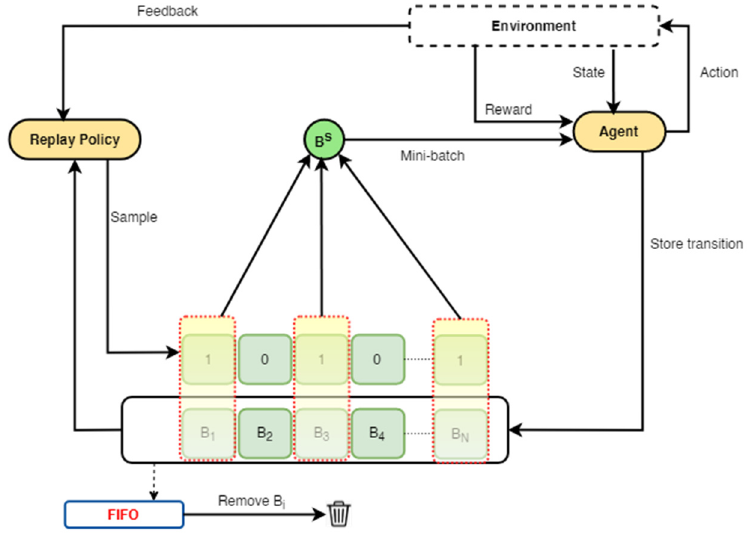
Figure 1. An illustration of the standard experience replay (ER) framework. A specified batch size of transitions is uniformly sampled at random from the replay buffer to train the agent. When the buffer is full, the First-In-First-Out (FIFO) retention strategy is applied to ensure that older transi- tions are replaced with newer ones.